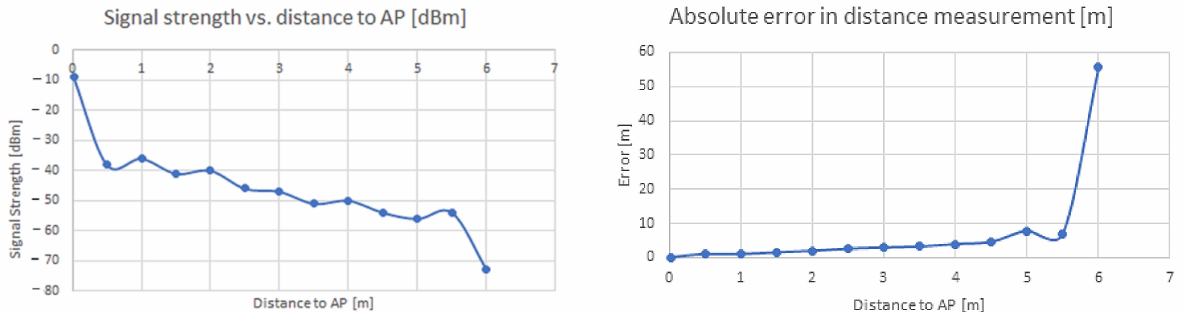
Figure 9. Variation of signal strength with distance ( left ), and absolute error in distance measurement ( right )—equipment Huawei AP, mixed indoor environment (LoS +